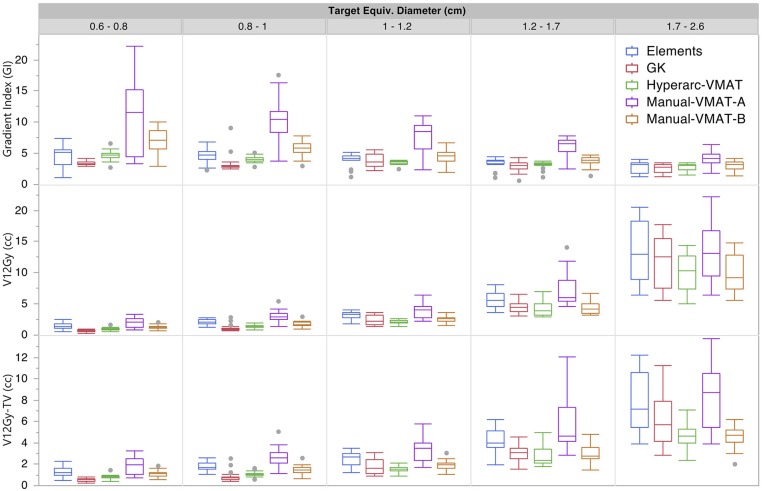
Gradient Index (GI), V12Gy per target (defined as the volume of 12Gy delivered to the surrounding brain tissue contributed only from that individual target), and V12Gy-TV(defined as the total volume of brain receiving 12Gy per target excluding the target volume) results displayed as box plots per SRS plan type, divided into five separate target size diameter bins.